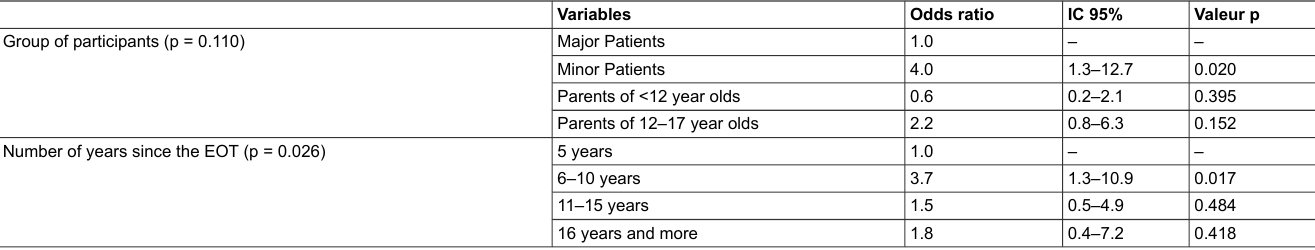
Table S6: Psychological self-assessment.